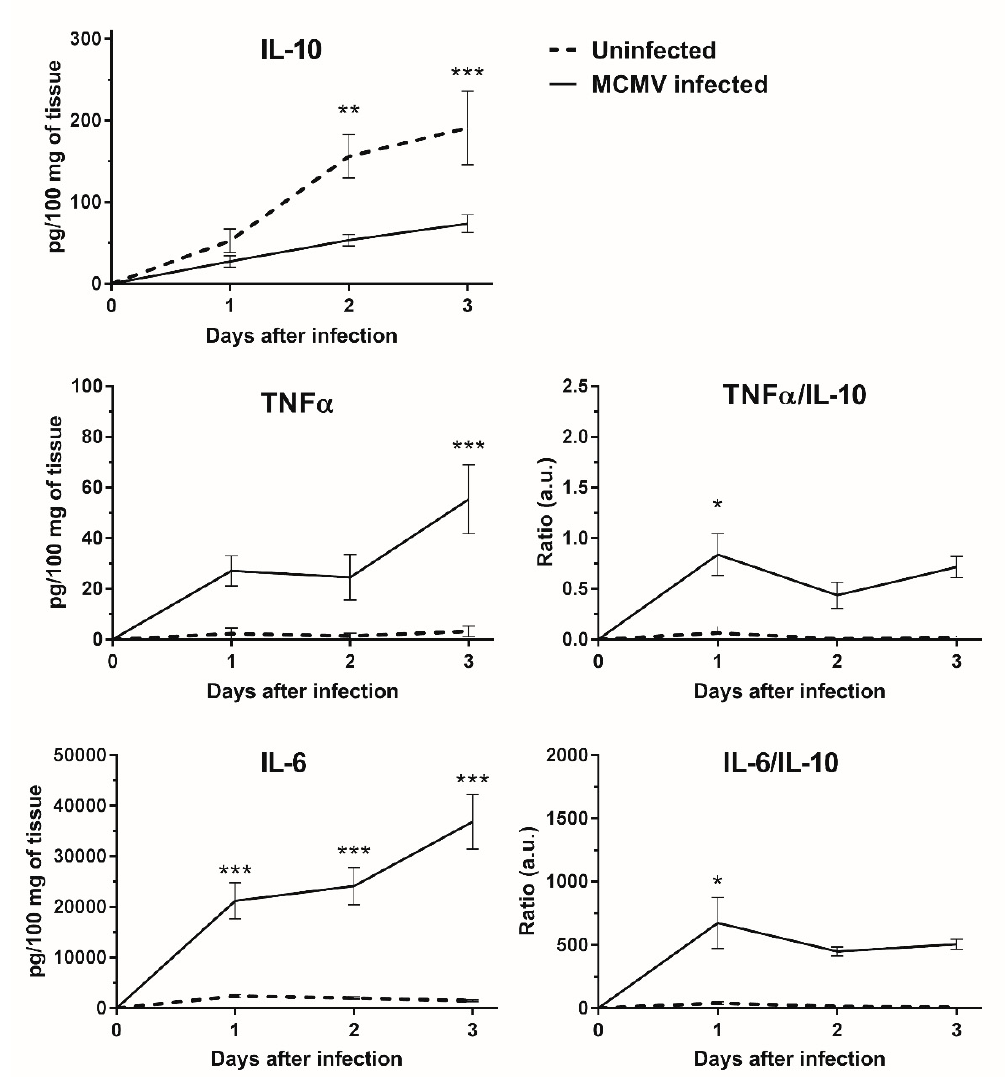
Figure 5. Inflammatory cytokines secreted by murine GWAT explant cultures after infection with MCMV. Explants were infected with 100,000 PFU / mL of MCMV or mock infected (isovolumetric